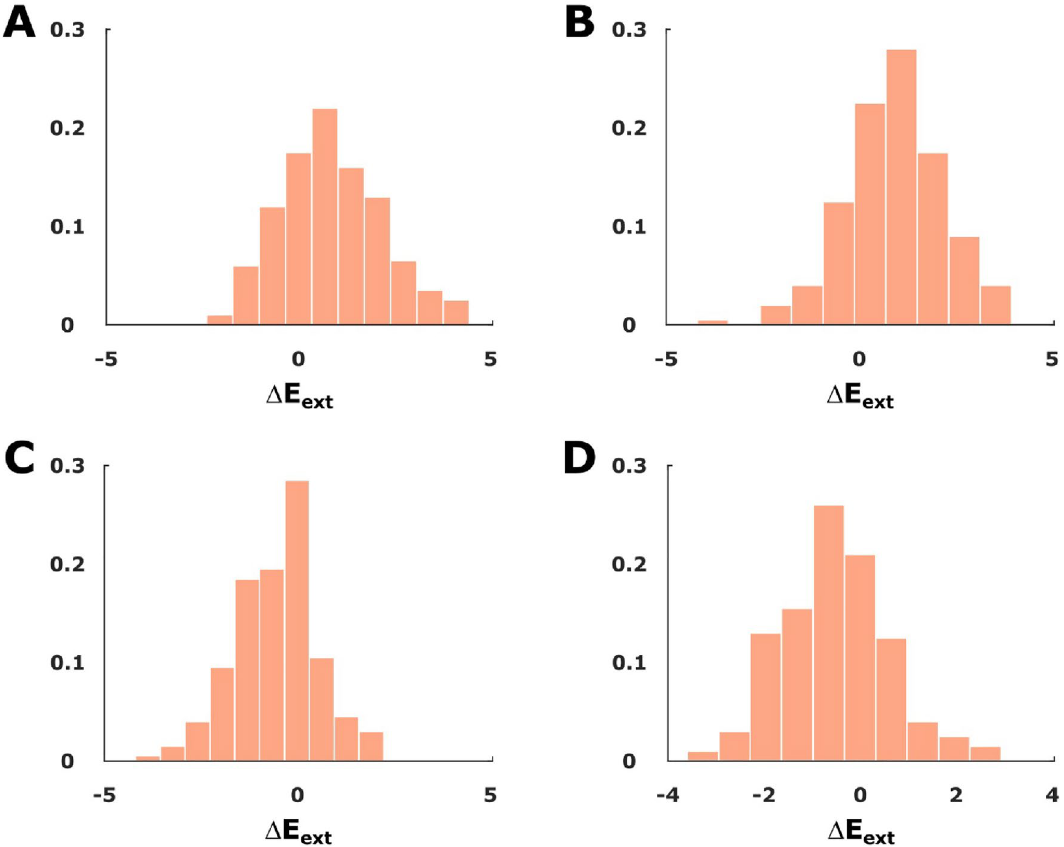
Figure 9. Histogram of the forward driving signal values using different values of b . In particular, we present the histograms for b = 1, − 1, 10, − 10 . We include the first two since they are close to the values of b we fit from the initial 100 trials (where no deviation is applied) and the last two to illustrate the grounds on which we discard certain parameter pairs. As expected from the observed hysteresis effect (cf. Fig. 3), the histograms in ( A ) and ( B ), which correspond to b = 1 and b = − 1 , respectively, are biased towards positive values of the driving signal. When assuming implausible parameters, like the ones in ( C ) and ( D ), which correspond to b = 10 and b = − 10 , respectively, the bias shifts towards negative values (cf. C , D ) and, even, shows a significant concentration of values around 0 (cf. C ). Note we observe, respectively, the same biases in the backward driving signals.